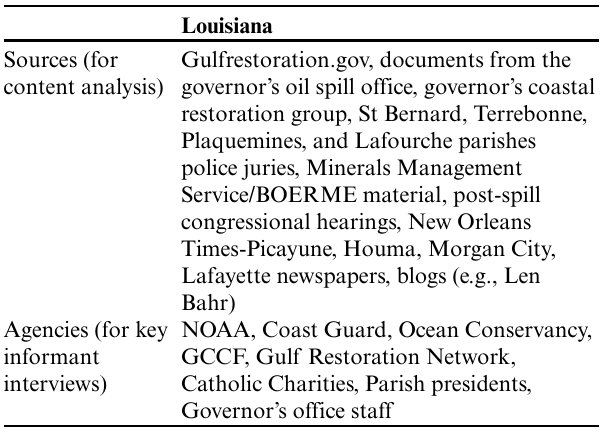
Table 1 . Major sources and agencies for content analysis